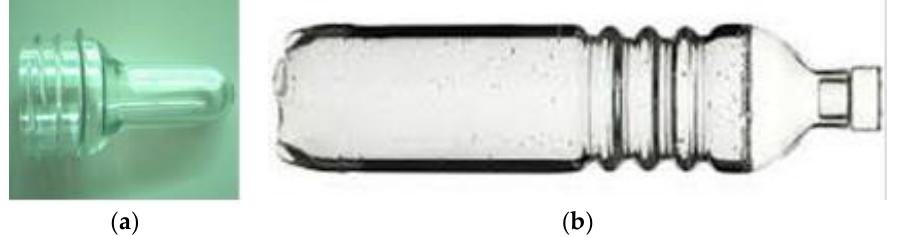
Figure 2. ( a ) Preform in PET (polyethylene terephthalate), from which the bottle is obtained through a thermoforming process; ( b ) example of the final geometric complexity of a bottle.